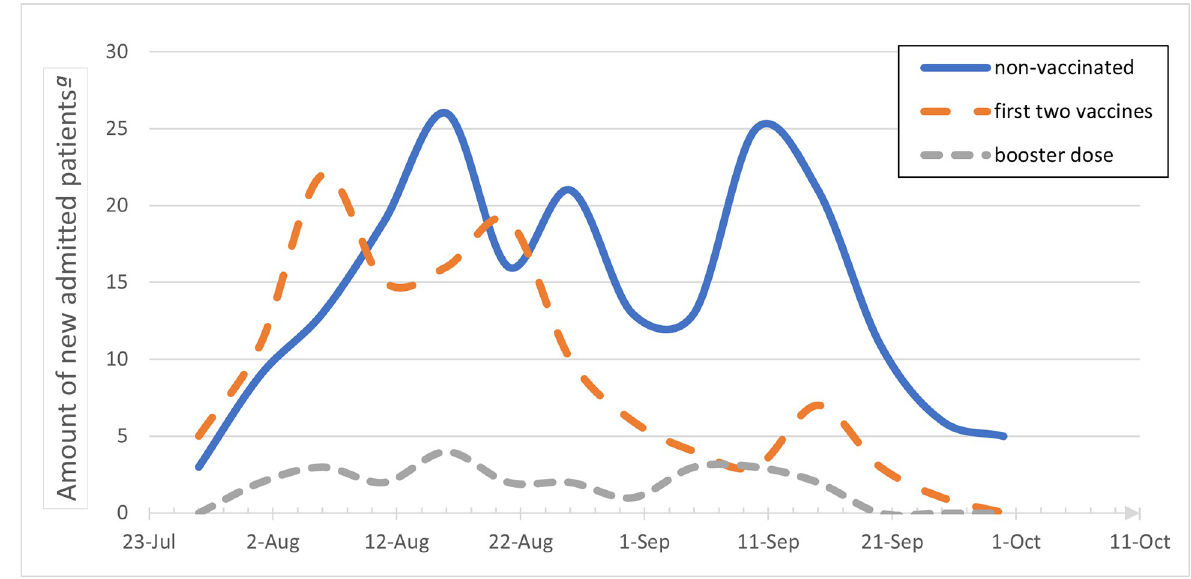
Fig 1. Trends in hospital admission of severe COVID-19 patients divided by the vaccine status. ª Present the total amount of patients admitted during the study period, analyzed by the combined number in 5-days intervals.